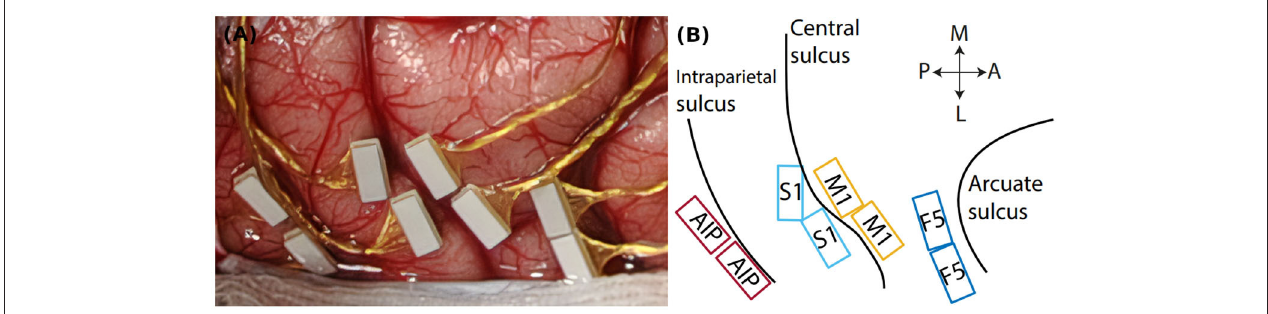
FIGURE 1 | Cortical implantation sites. (A) Intrasurgical picture, showing the floating microelectrode arrays (white rectangles) implanted in parietal and frontal cortex. (B) Implantation schematic with implantation sites in parietal area AIP, somatosensory cortex (S1), primary motor cortex (M1), and premotor cortex (area F5). Black lines indicate cortical sulci. Double arrows indicate the medio-lateral (M-L) and posterior-anterior (P-A)